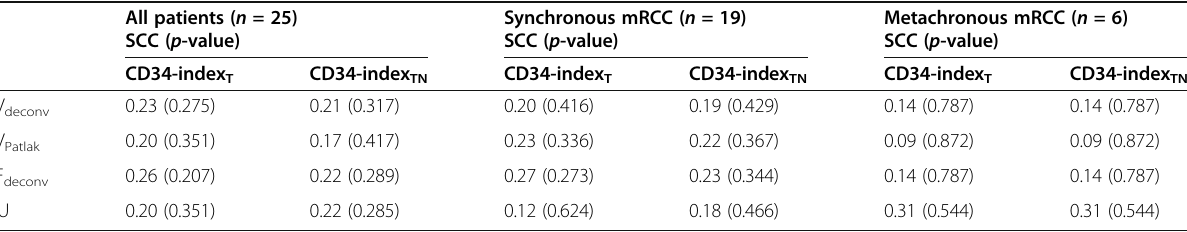
Table 3 Correlations between DCE-CT parameters, HU, and CD34-index at baseline All patients ( n = 25) SCC ( p